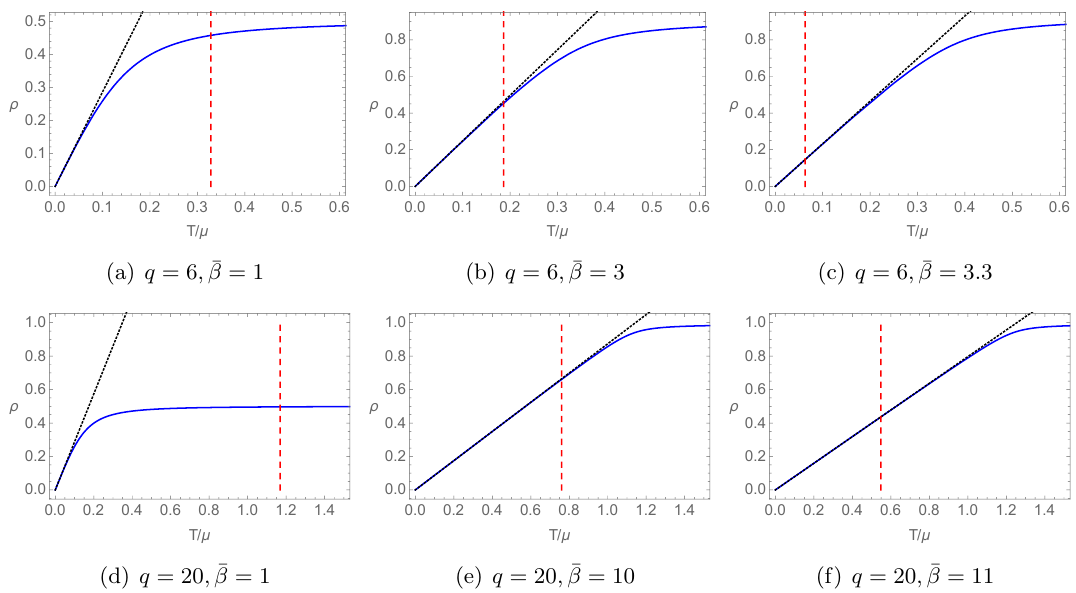
Figure 3 . Resistivity vs temperature of the superconductor model with q = 6 (top) and q = 10 (bottom). The vertical red dotted line displays the phase transition temperature, which is higher for bigger q and smaller (cid:22) (cid:12) . For bigger (cid:22) (cid:12) , the linear- T resistivity survives above the phase transition as shown in (cid:12)gures (c) and